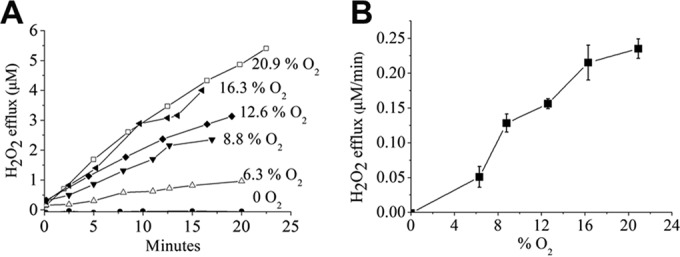
The rate of H2O2 production in B. thetaiotaomicron is proportionate to the ambient O2 concentration. Log-phase B. thetaiotaomicron Hpx− cells were resuspended in PBS-glucose at an OD600 of 0.1. H2O2 production was monitored at different levels of dissolved O2.